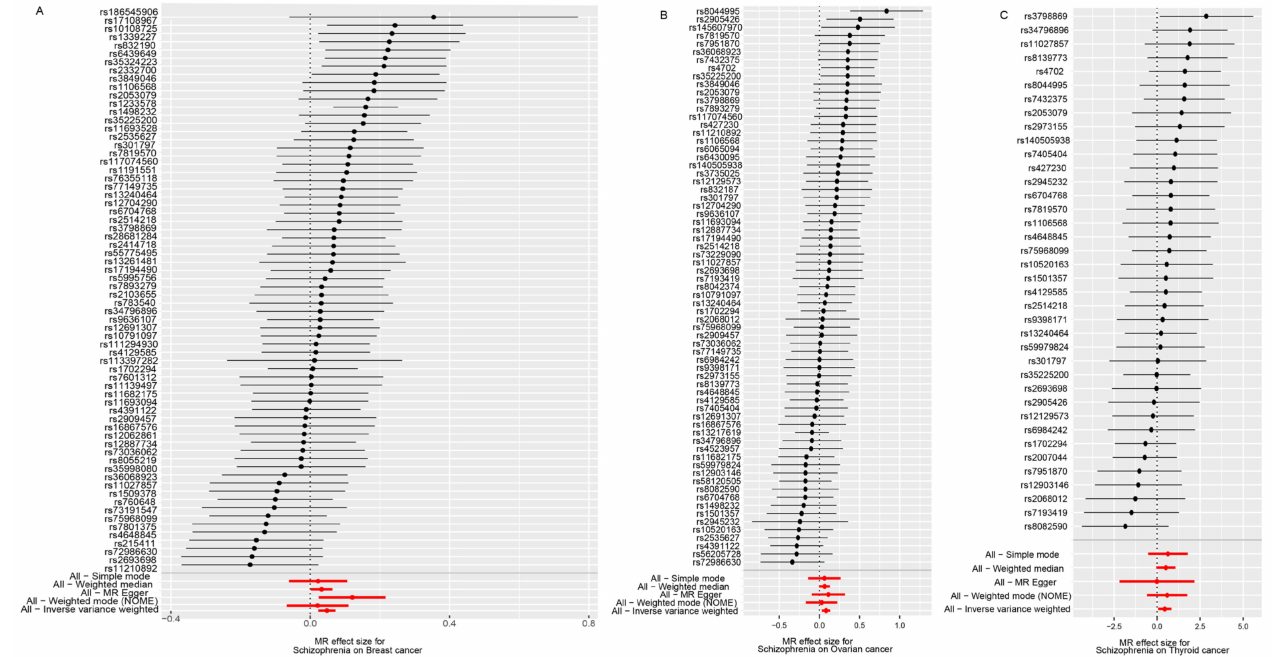
Figure 2. Estimated positive causal effects of genetically increased SCZ risk on three cancers risk. Forest plot representing the causal estimation of SCZ risk on ( A ) breast cancer, ( B ) ovarian cancer, and ( C ) thyroid cancer risk using each or all variants. Red lines are the causal effect of exposure on outcome is estimated using all SNPs using different methods.